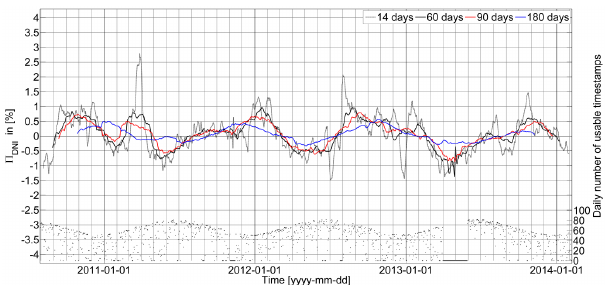
Figure 3. DLR2008: time series of (cid:53) DNI for varying calibration duration for RSP-4G-08-10-3 with daily number of usable times- tamps. (cid:53) DNI represents the deviation of calibration results from a long-term calibration for DNI.